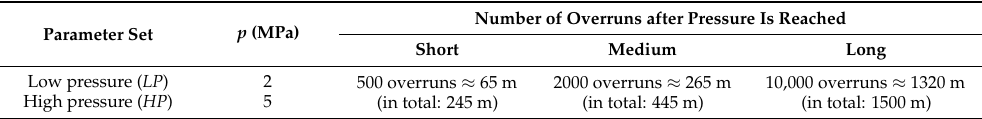
Table 2. Experimental setup of pin-on-disc